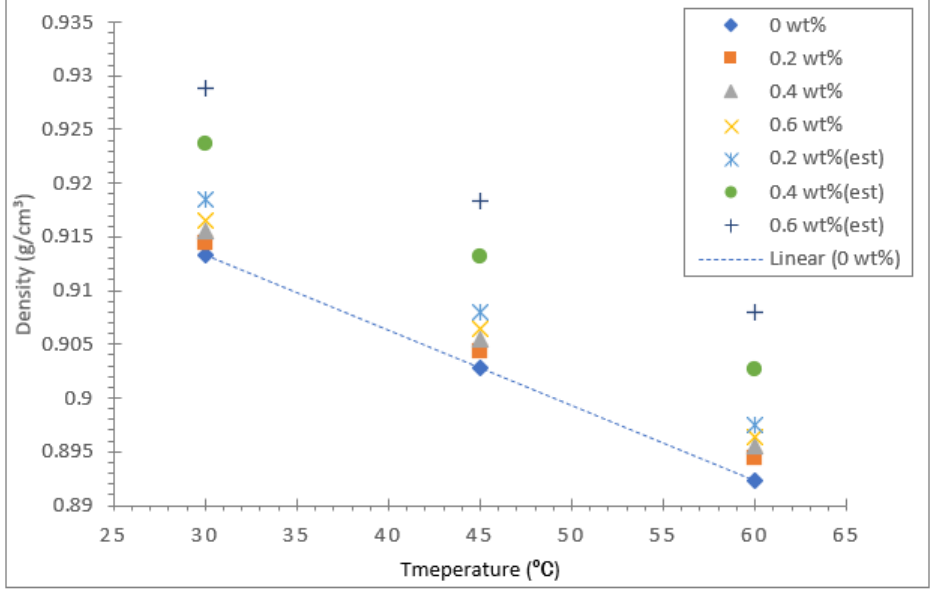
Figure 16. Density of soybean oil/Al 2 O 3 -TiO 2 hybrid nanofluid.